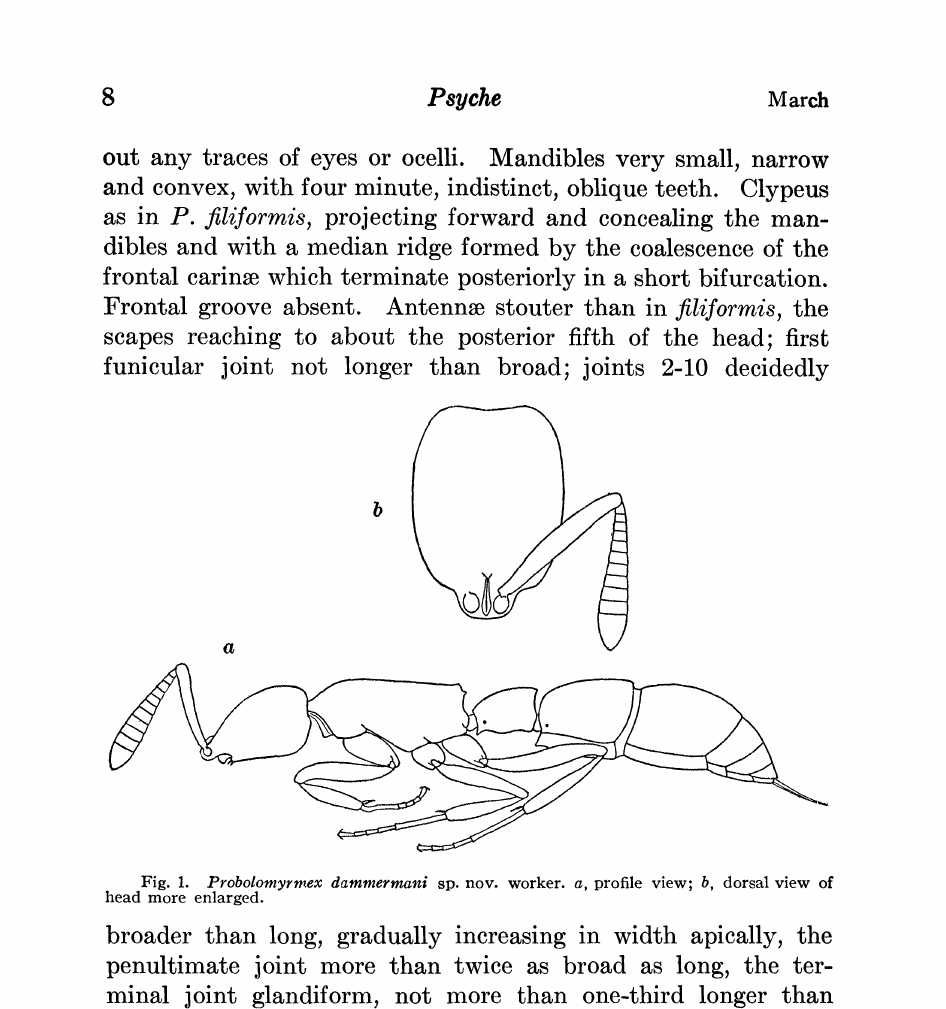
Fig. 1. Probolomyrmex dammermani sp. nov. worker, a, profile view; b, dorsal view of head more enlarged. broader than long, gradually increasing in width apically, the penultimate joint more than twice as broad as long, the ter- minal joint glandiform, not more than one-third longer than broad and scarcely as long as the three preceding joints together. Thorax shaped much as in filiformis, long and narrow, without sutures, the dorsal outline even and straight, except anteriorly where it is feebly